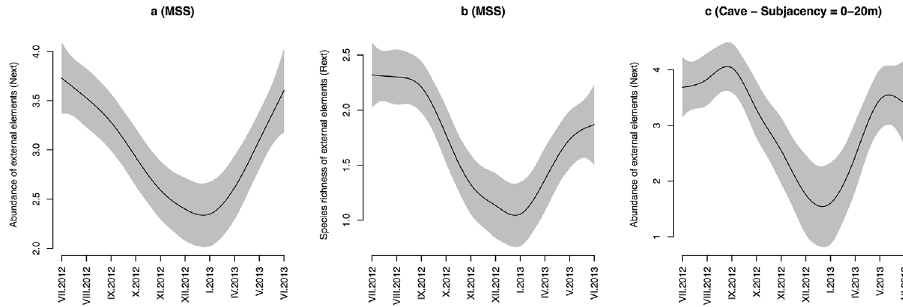
Figure 6. Predicted values (black line) and 95% confidence intervals (grey surface) of the effect of the sampling series (Serie_i) on the abundance of external elements in the MSS ( a ), on the species richness of external elements in the MSS ( b ) and on the abundance of external elements in the cave at subjacency of 0–20m ( c ) derived from GAMM analyses. Only fixed effects are